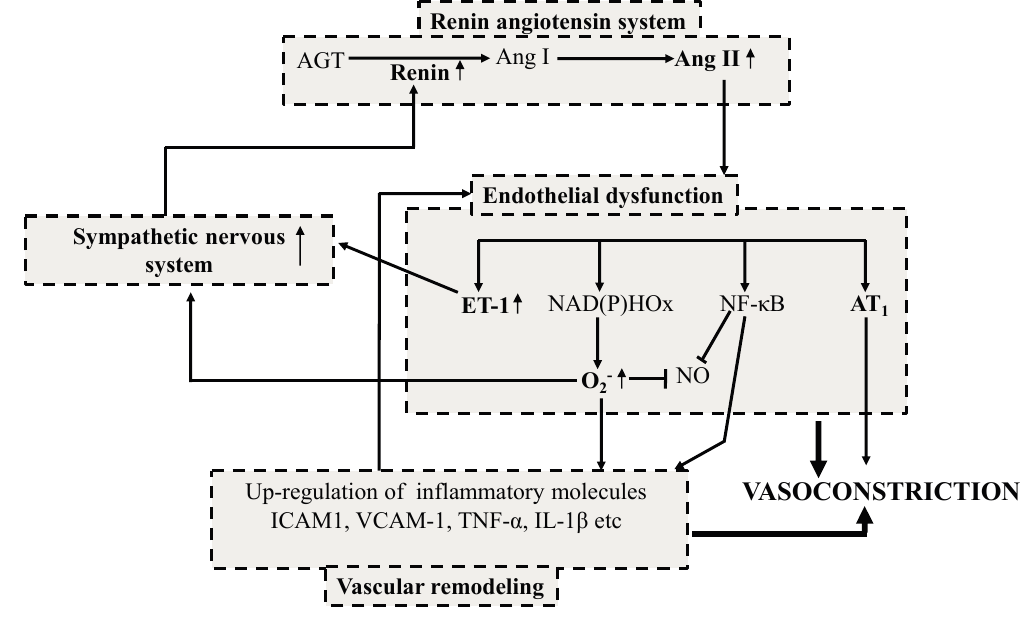
Figure 4. Pathophysiology of hypertension—a vicious cycle. Renin angiotensin system (RAS), endothelial dysfunction, vascular remodeling, and activity of sympathetic nervous system are correlated with each other. Enhanced RAS activity leads to over production of angiotensin II (Ang II) which accelerates endothelial dysfunction. Ang II induced endothelial dysfunction results in vasoconstriction as well up regulates the activity of transcription factors (such as NF- κ B, nuclear factor κ B), promoting vascular inflammation. Vascular ICAM-1 (Intercellular adhesion molecule 1), VCAM-1 (Vascular adhesion